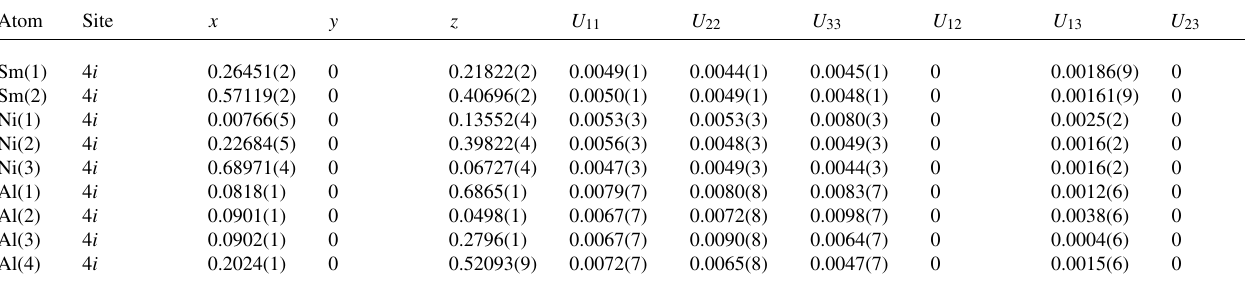
Table 2. Atomic coordinates and displacement parameters (in Å 2 ) . Atom